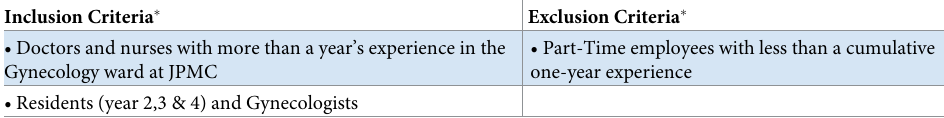
Table 2. Eligibility criteria of study